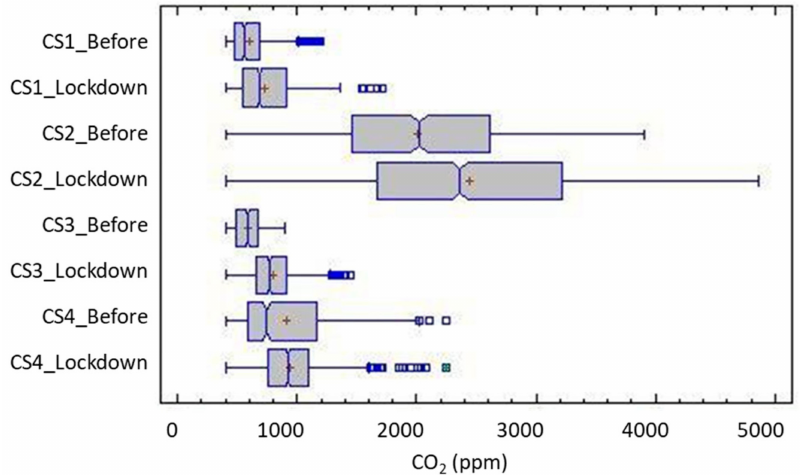
Figure 9. Box and whisker graph of CO 2 concentration for the case studies before and during the lockdown in